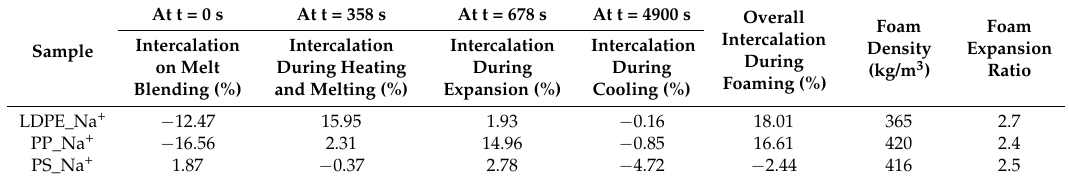
Table 6. Intercalation on melt blending, foaming, and overall intercalation degree, final foam densities, and foam expansion ratios achieved with the different types of nanoclays in the materials with Na + .